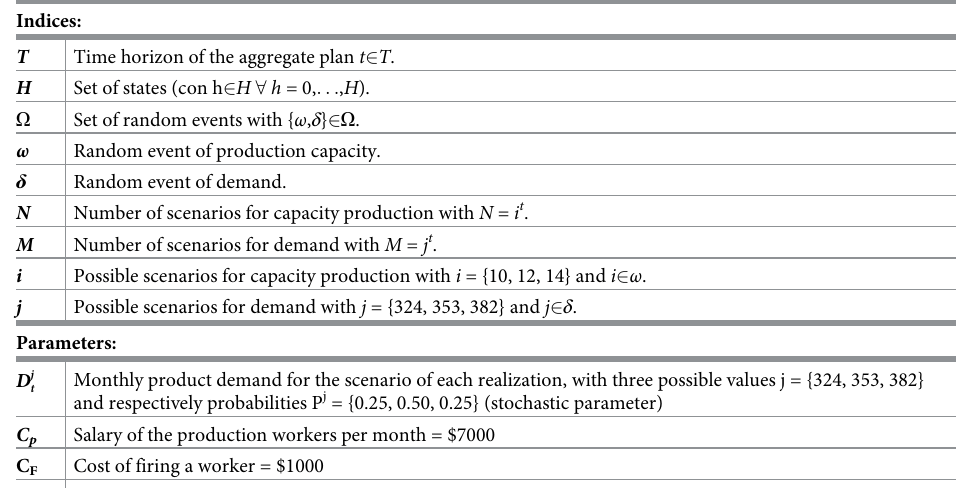
Table 4. Notation of the stochastic model